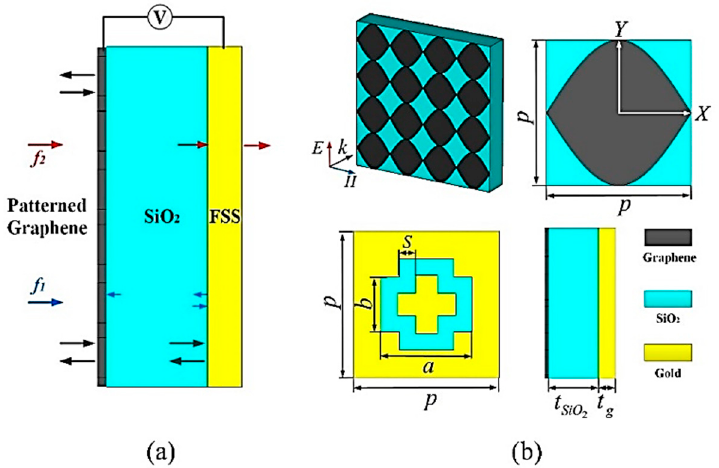
Figure 1. Structure of the controllable terahertz metamaterial absorbers (TMA). ( a ) Profile sketch, ( b ) unit cell. The dimension values are set as p = 80, a = 50, b = 30, s = 10, t SiO2 = 55, t g = 0.5, unit: μ m.